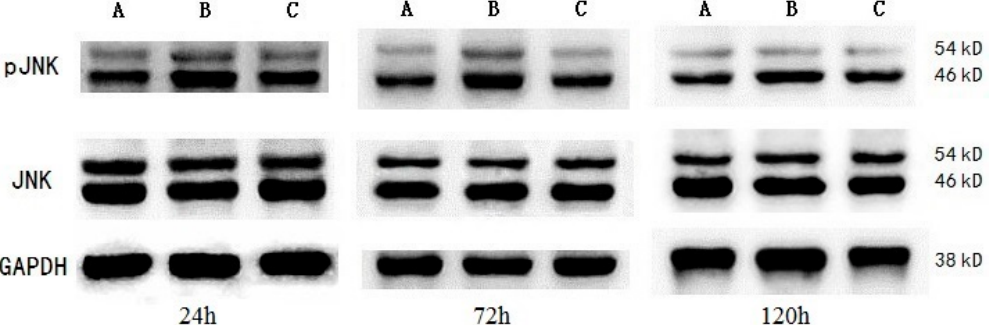
Figure 5. The expressions of pJNK and c-Jun NH 2 -terminal kinase (JNK) in peripheral region of hematoma at each time point, shown by Western blotting. ( A ) Sham-operated group; ( B ) ICH group; and ( C ) MIHA group.